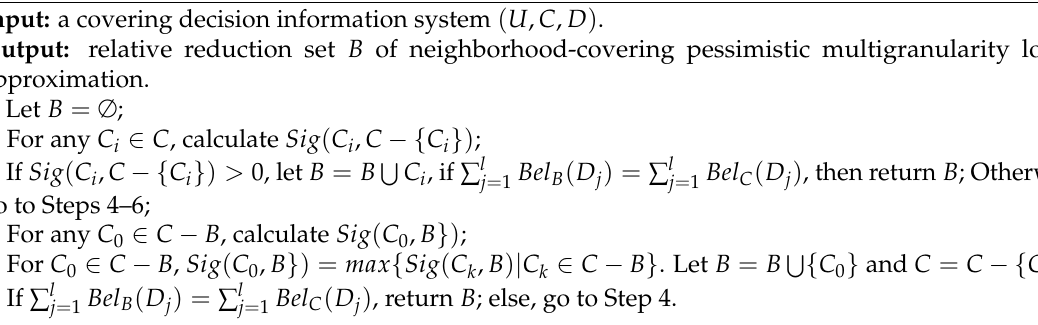
Algorithm 2 Relative reduction algorithm of neighborhood-covering pessimistic multigranularity lower approximation based on evidence